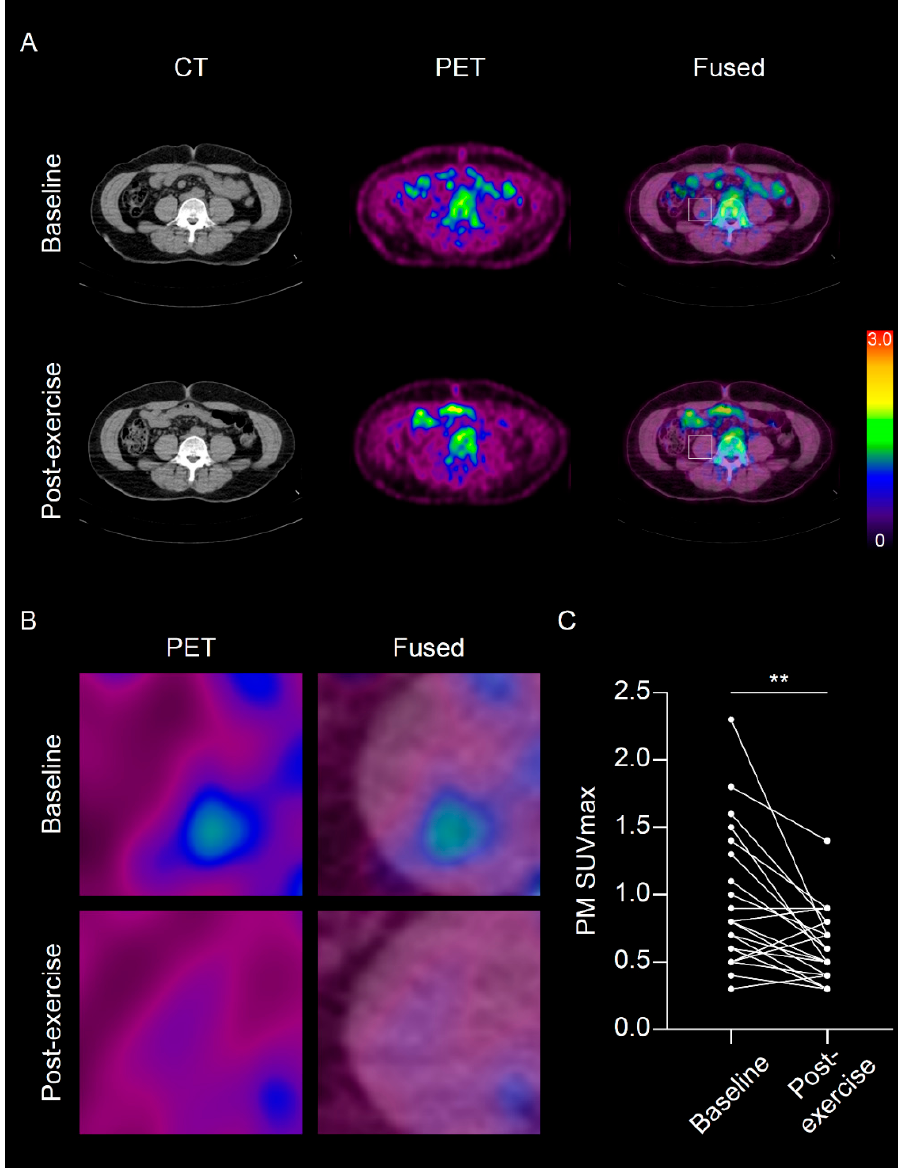
Figure 2. Physical exercise significantly attenuated the maximum standardized uptake value of psoas muscle (PM SUVmax). ( A ) Representative images of 18 F-fluorodeoxyglucose (FDG) positron emission tomography/computed tomography (PET/CT) at baseline and post-exercise; ( B ) Magnified images of psoas muscle; ( C ) Change in PM SUVmax between baseline and post-exercise. ** p < 0.01.